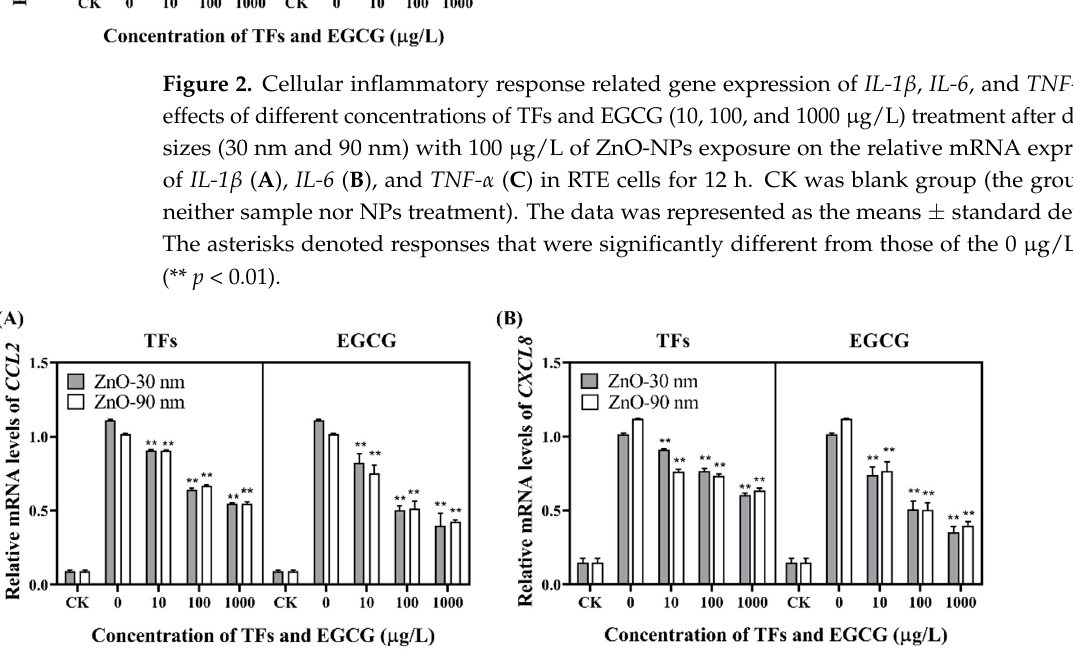
Figure 3. The relative gene expression of inflammatory cytokines CCL2 ( A ) and CXCL8 ( B ). Different concentrations of TFs and EGCG (10, 100, and 1000 µ g/L) treatment after different sizes (30 nm and 90 nm) with 100 µ g/L of ZnO-NPs exposure in RTE cells for 12 h. CK was blank group (the group with neither sample nor NPs treatment). The data was represented as the means ± standard deviation. The asterisks denoted responses that were significantly different from those of the 0 µ g/L group (** p <